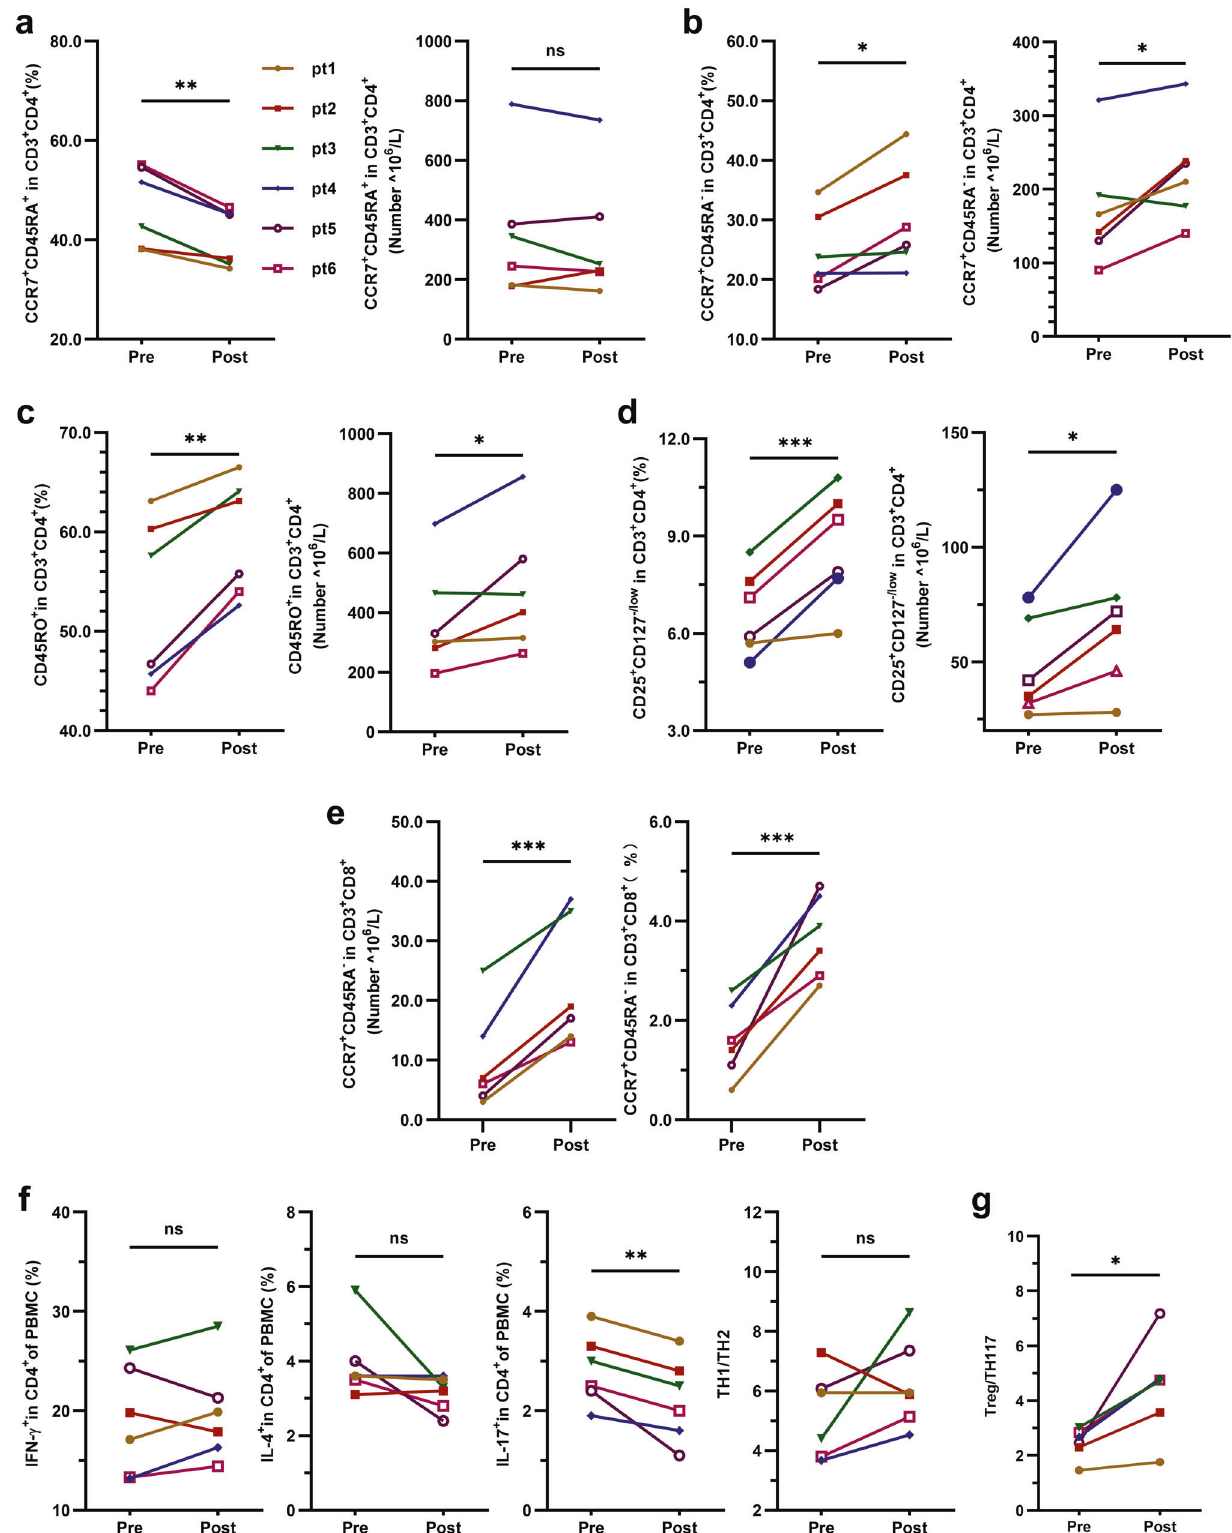
Fig. 7 The changes in T lymphocyte subsets in responders pre- and post-UMSCT. a – e Changes of frequencies and numbers of CD4 naive T, CD4 + TCM, CD4 + memory T, Treg and CD8 + TCM cells in PB in responders ( n = 6, * P < 0.05, ** P < 0.01, *** P < 0.001); f − g Changes of frequencies of Th1, Th2, Th17 and Th1/Th2 and Treg/Th17 in PB in responders ( n = 6, * P < 0.05, ** P < 0.01)